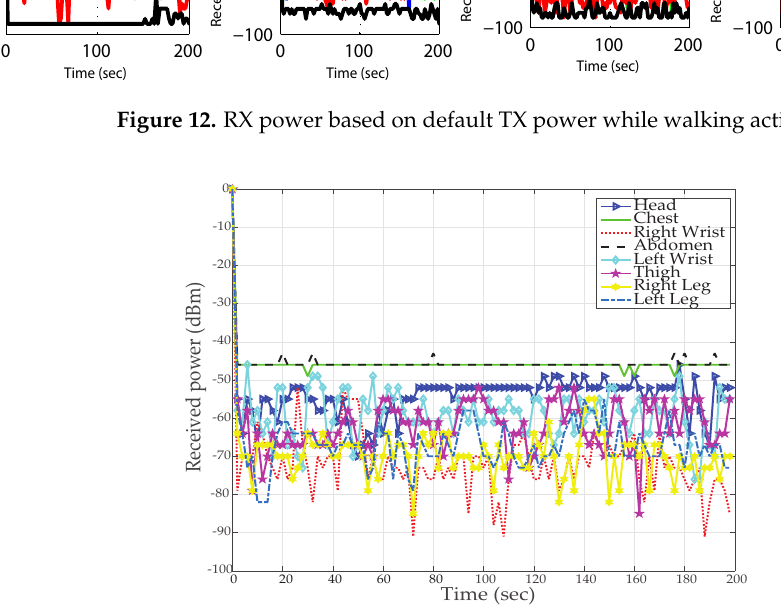
Figure 13. RX power using proposed dynamic control algorithm while walking